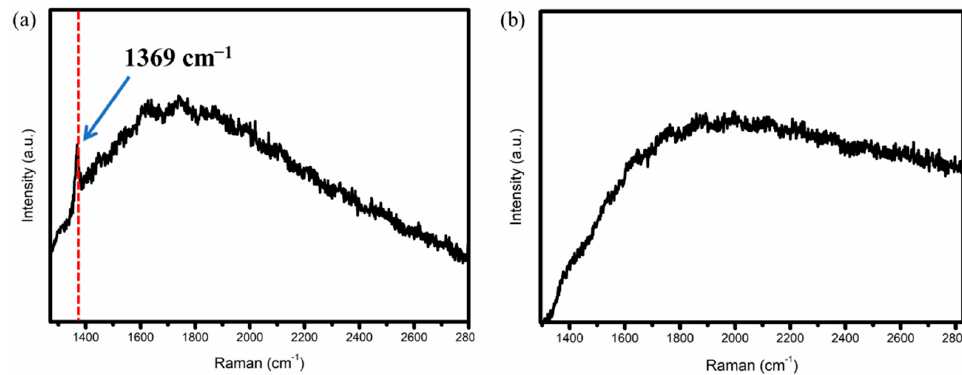
Figure 8. ( a ) Raman peaks transferred from h-BN grown on Ni-containing 5% Cu-Ni alloy substrates to SiO 2 /Si, ( b ) Raman peak of SiO 2 /Si.